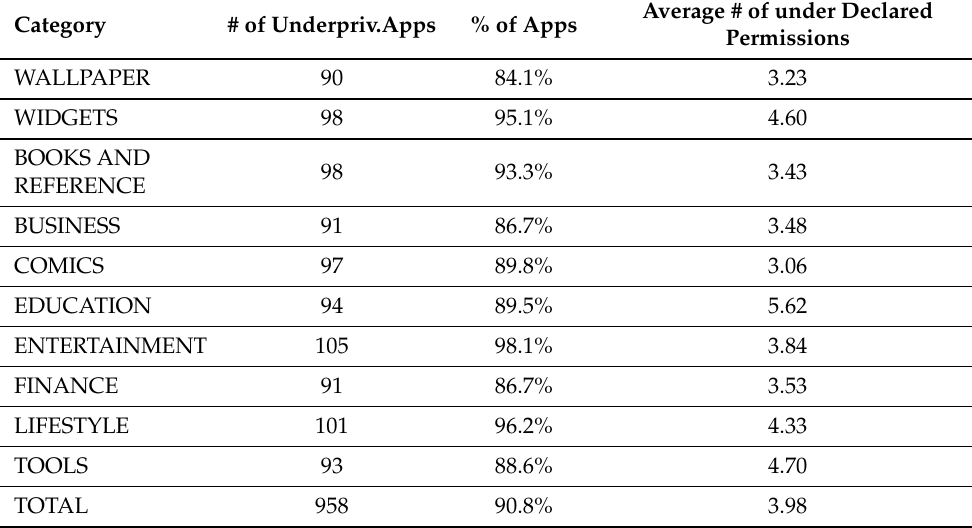
Table 1. Permission underprivilege analysis